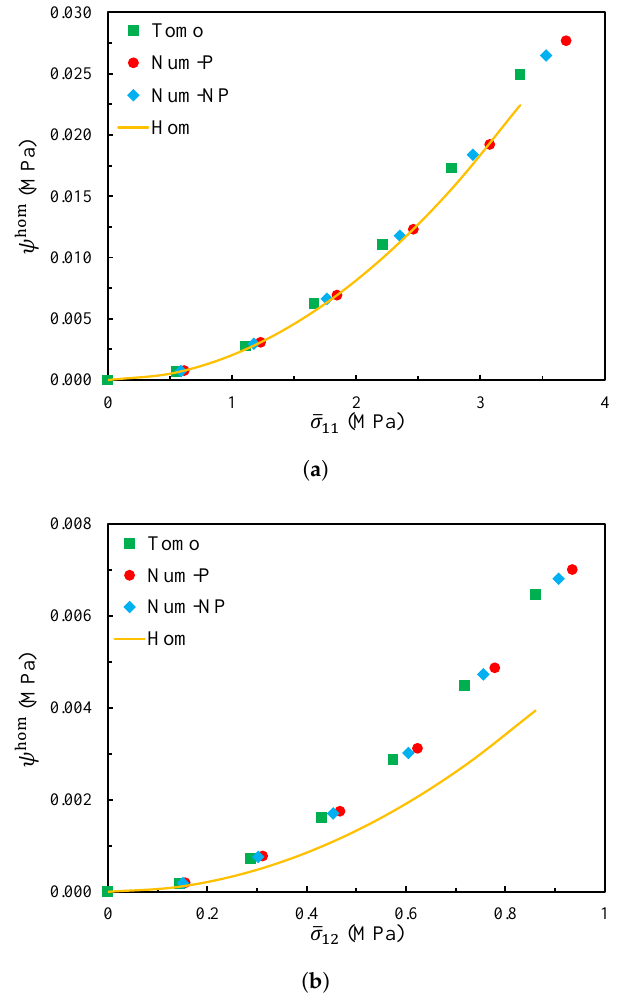
Figure 14. The evolution of the energy density as a function of ( a ) σ 11 and ( b ) σ 12 for each